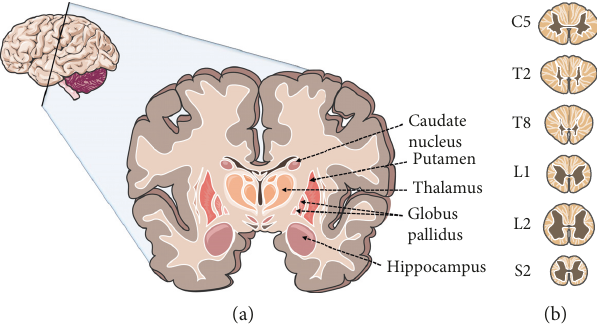
Figure 5: Typical cross sections. (a) Brain; (b) spinal cord.